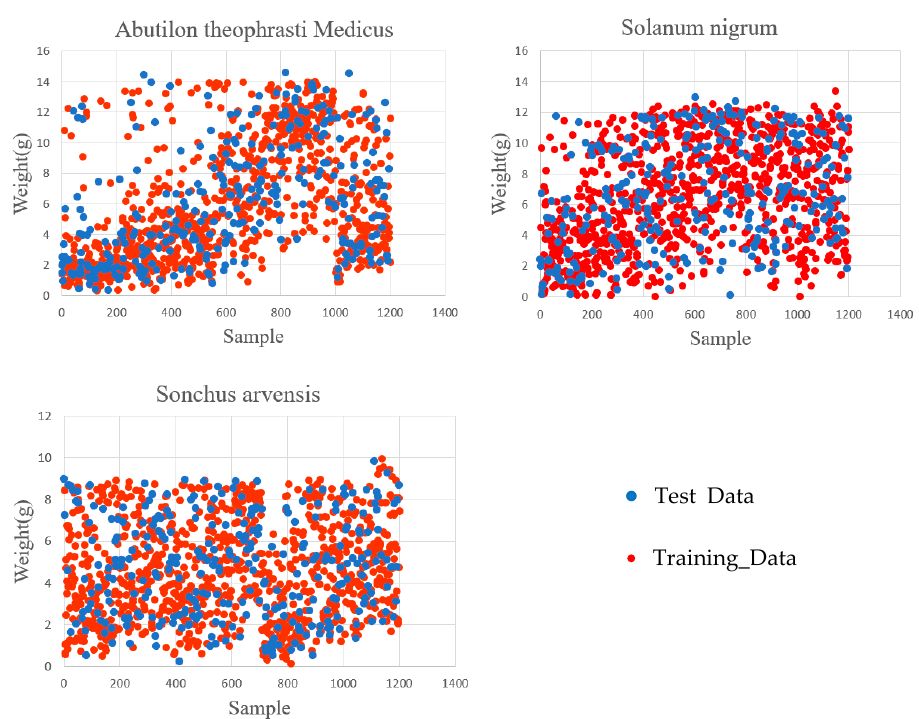
Figure A2. Training set2 and test set2 distributions.